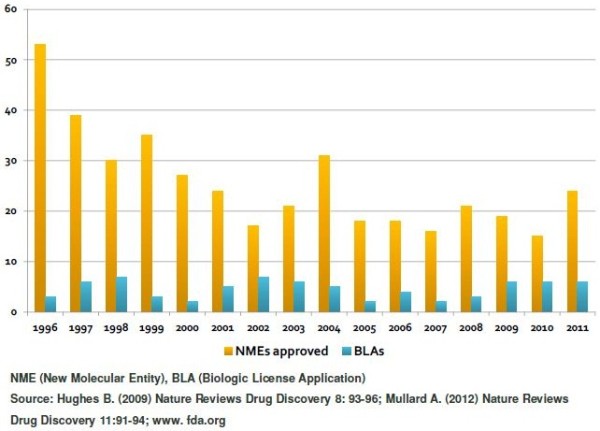
FDA drug approvals.